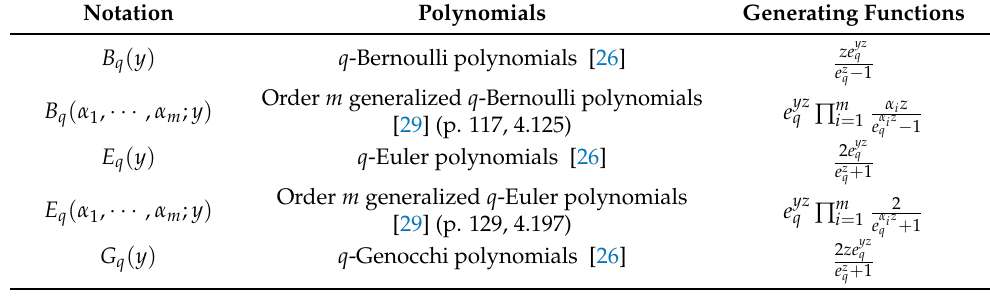
Table 1. Generating the function of some q -Appell type